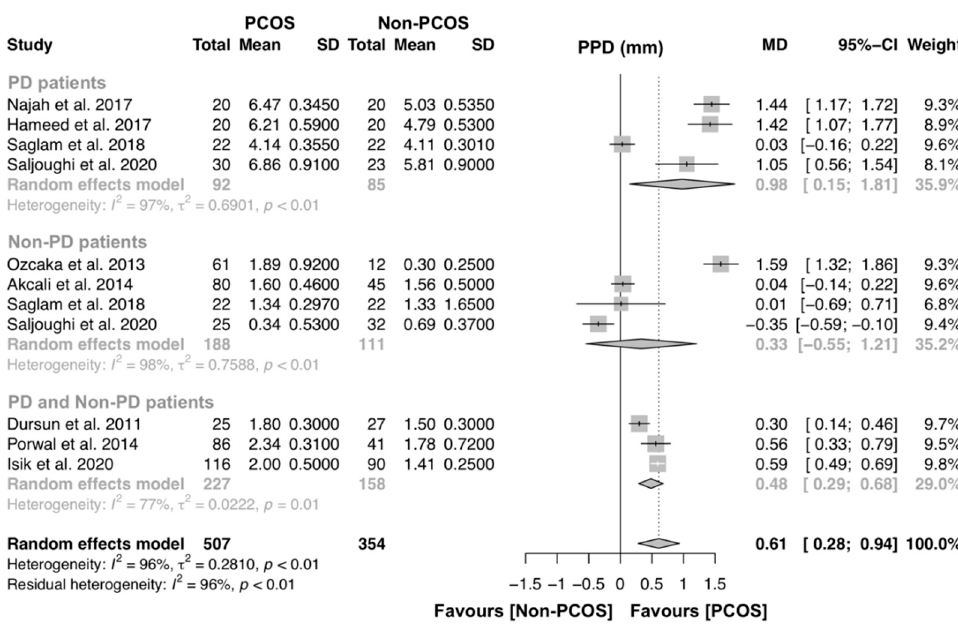
Figure 5. Forest plot of studies evaluating periodontal probing depth (PPD) levels in PD patients with and without PCOS (p-value = 0.0003). Mean effect size estimates have been calculated with 95% confidence intervals and are shown in the figure. Area of squares represents sample size, continuous horizontal lines and diamonds width represents 95% confidence interval. Diamond and the vertical dotted line represent the overall pooled estimate.